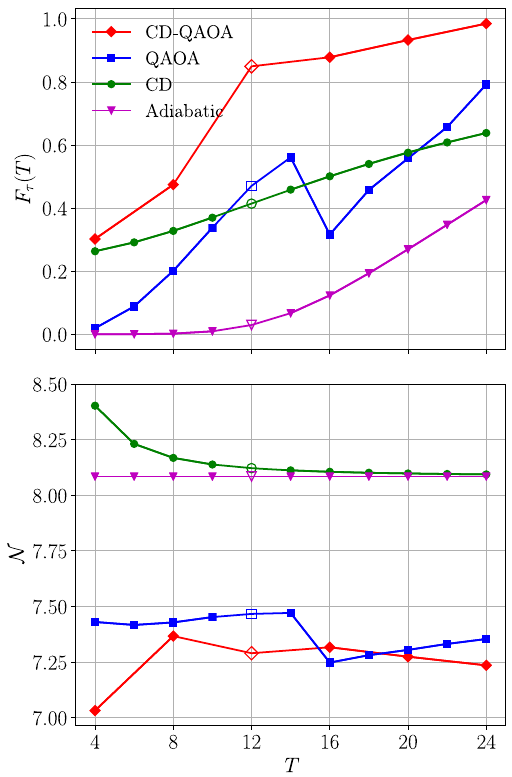
FIG. 23. Spin-1 Ising model: energy minimization against different protocol duration T for four different optimization methods: CD-QAOA (red line), conventional QAOA (blue line), variational gauge potential (green), and adiabatic evolution (magenta). Two associated quantities are shown: many-body fidelity F τ (top panel) and normalized time-averaged energy density N over the protocol (bottom panel). The empty symbols mark the duration for which the evolution of physical quantities is shown in Fig. 24. The parameters are the same as in Fig. 7. (see main text for discussion of the model parameters). Using this model, we compare four state preparation techniques: CD-QAOA, conventional QAOA, CD-driving using a variational gauge potential, and adiabatic evolution.